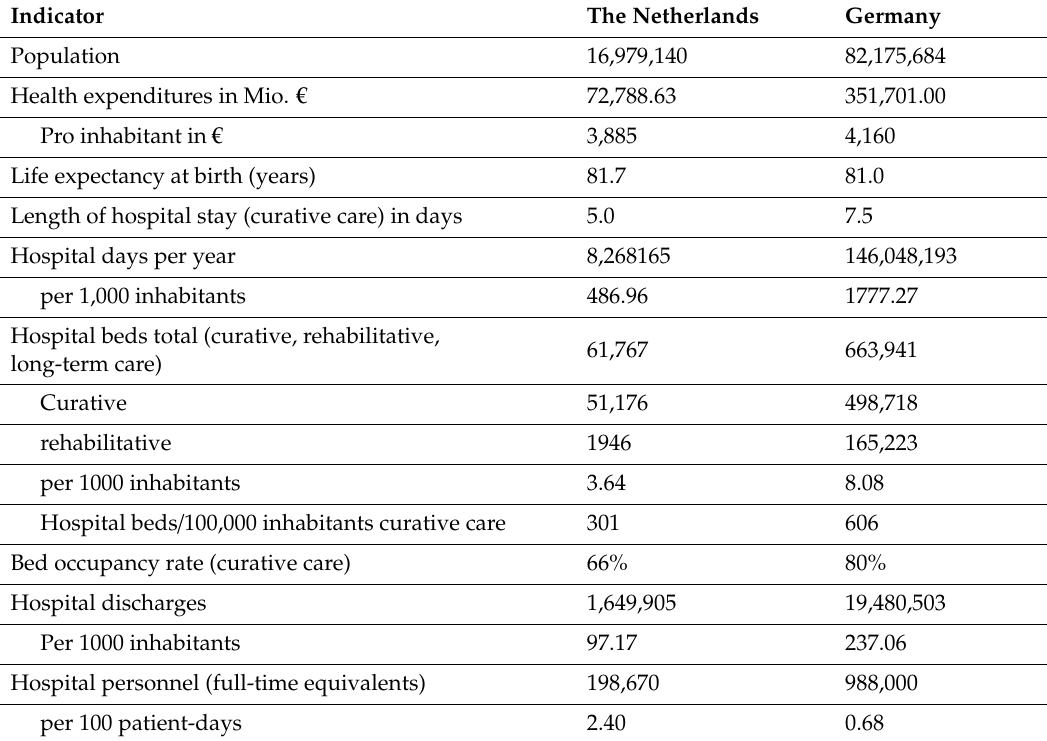
Figure 3. Antibiotic use in defined daily doses (DDD) per 100 patient-days for antibiotics belonging 101 to the J01 category according to the ATCC classification system [8]. 102 Table 3. Structures of the healthcare systems in The Netherlands and Germany